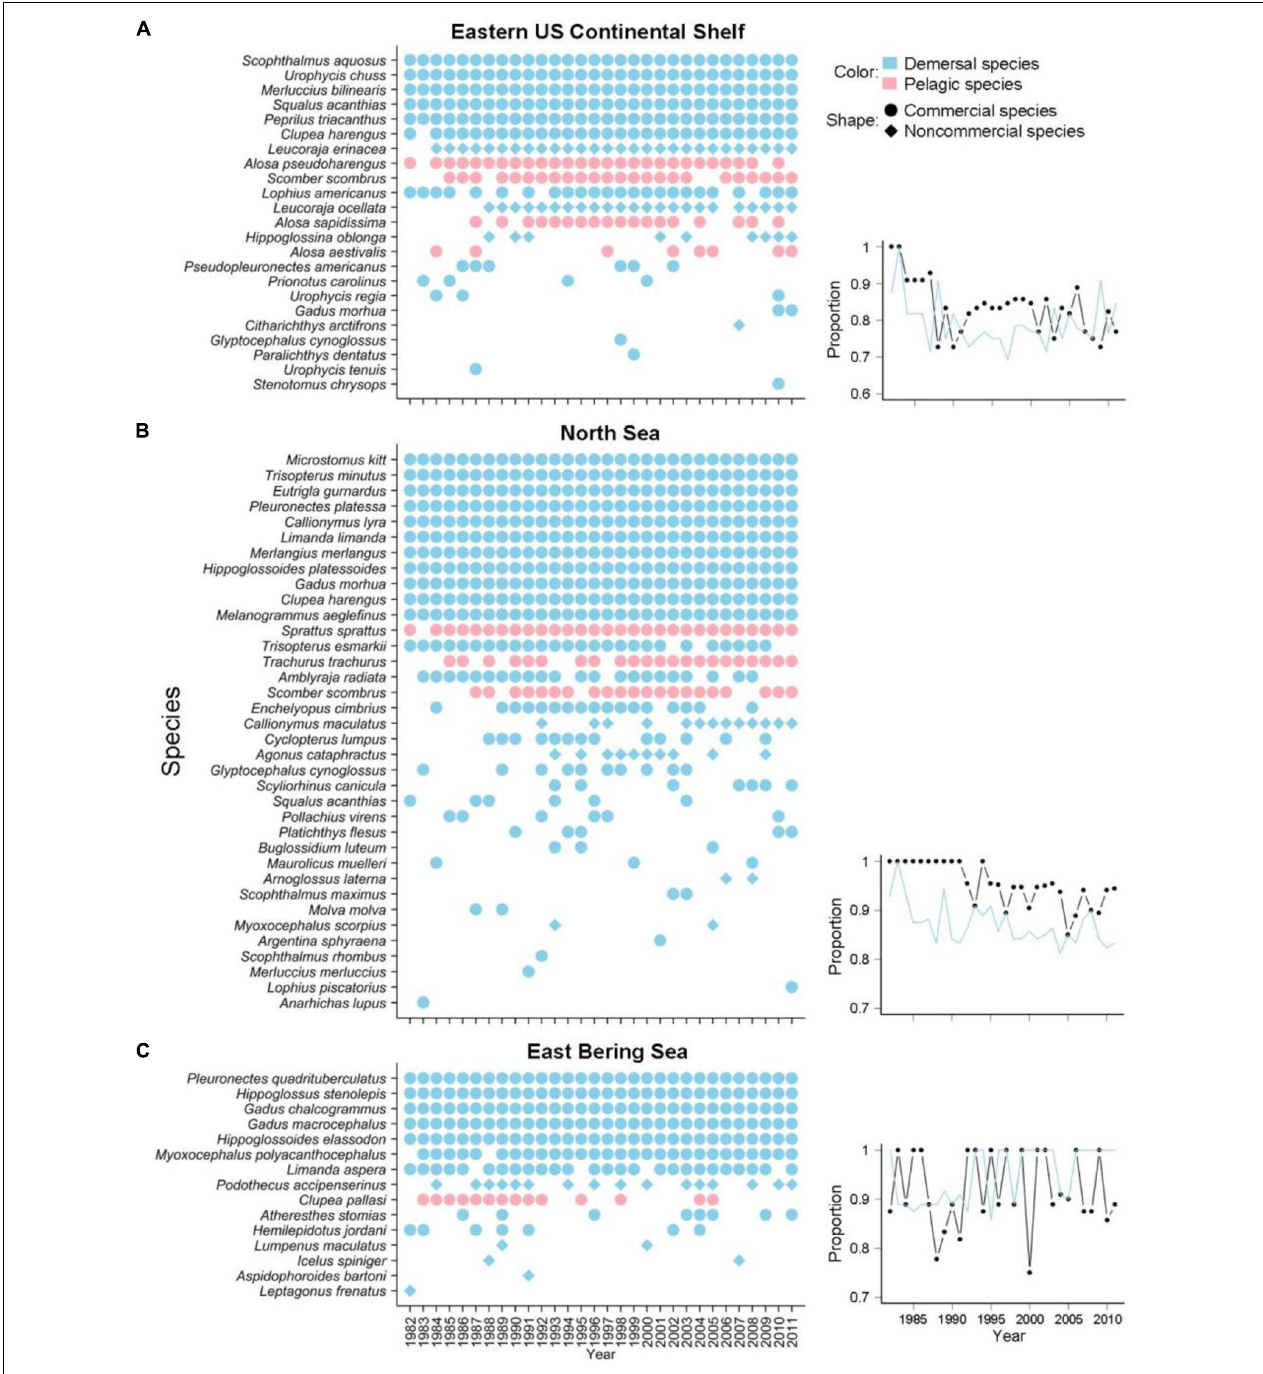
FIGURE 5 | List of potential keystone species defined according to a mean spatial robustness > 0.8 among species in the (A) Eastern US Continental Shelf, (B) North Sea, and (C) Eastern Bering Sea large marine fish communities. Habitat preference (demersal vs. pelagic species) is indicated by color (blue vs. pink, respectively), and commercial utilization (commercial vs. non-commercial species) is indicated by shape (circles vs. diamonds, respectively). The right panels provide the proportions of different guild groups (black: commercial species; blue: demersal species) in species